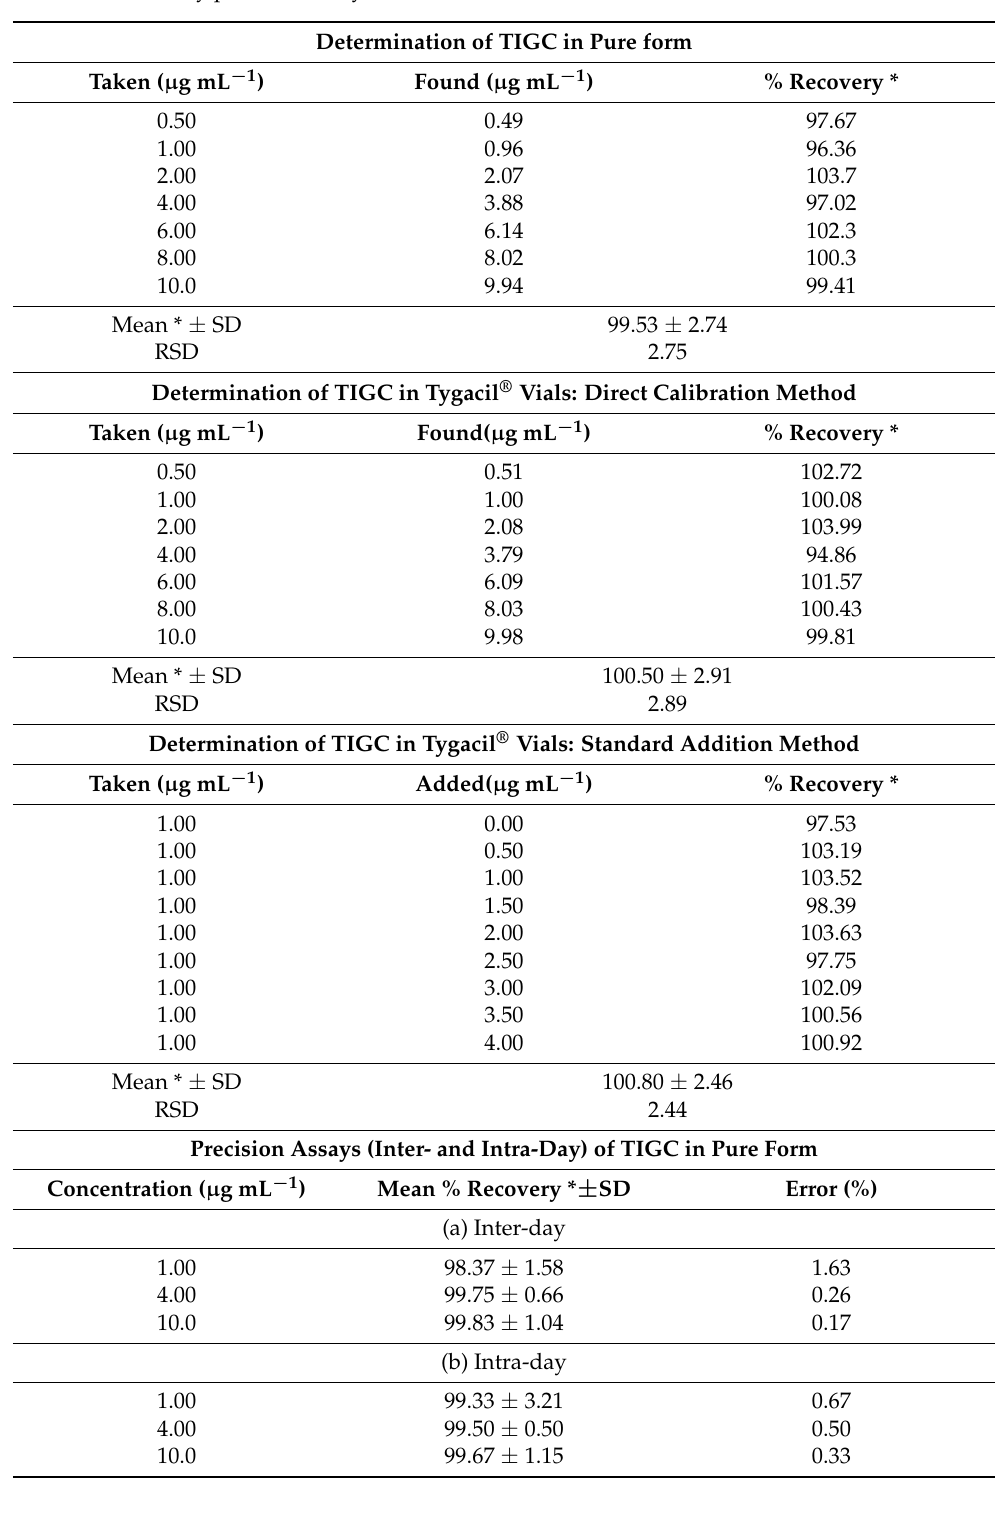
Table 6. Determination of TIGC as per se and in Tygacil ® vials operating the optimum conditions. Inter- and intra-day precision assays are